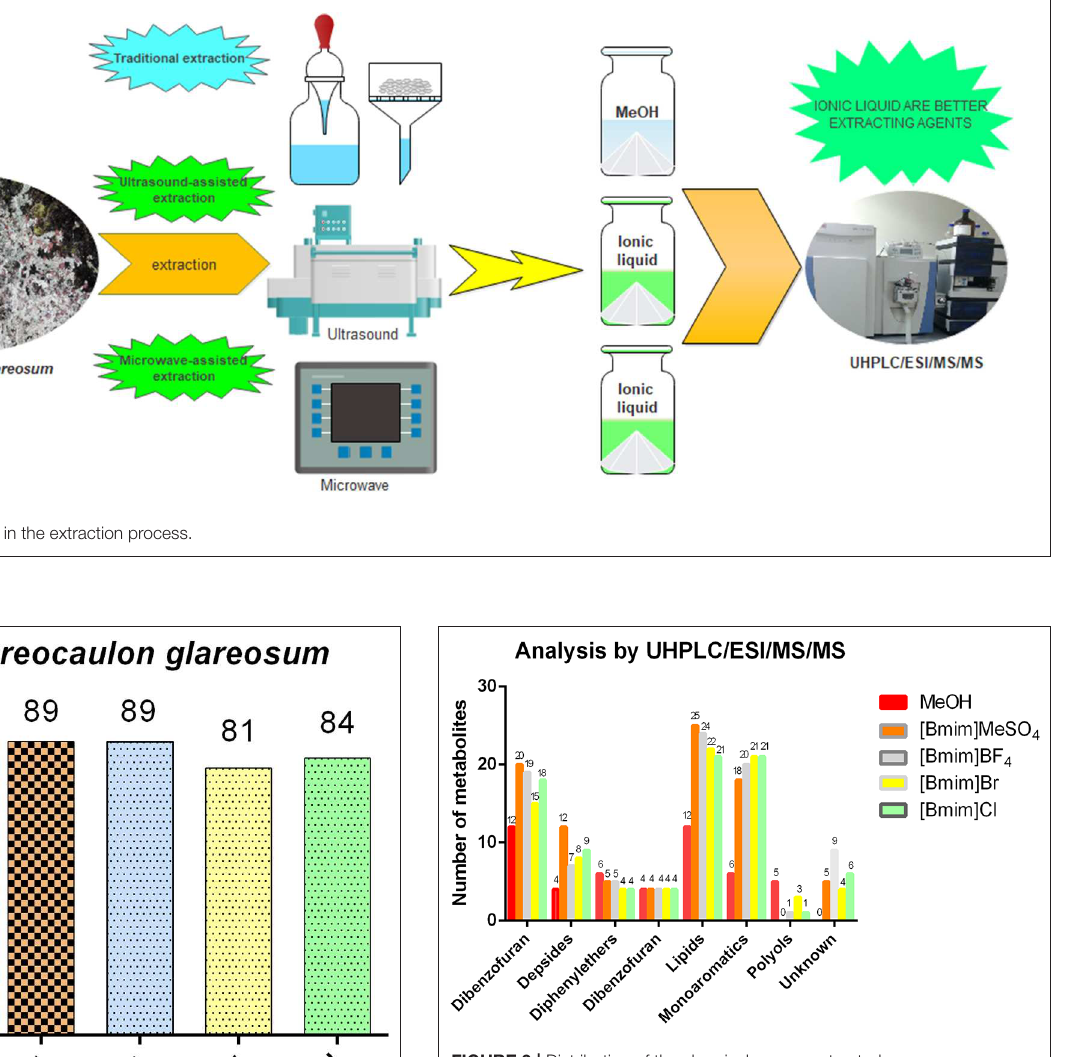
FIGURE 3 | Distribution of the chemical groups